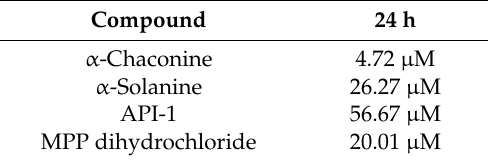
Figure 10. Dose and time-dependent cytotoxic effect and alteration of CI of API-1 determined by xCELLigence system: Effect of API-1 on proliferation of RL95-2 cell. Cells were treated with various concentrations of API-1 for 72 h. The CI was calculated from four repeated measurements. Table 1. IC 50 values of RL95-2 cells for 24 h 1 .